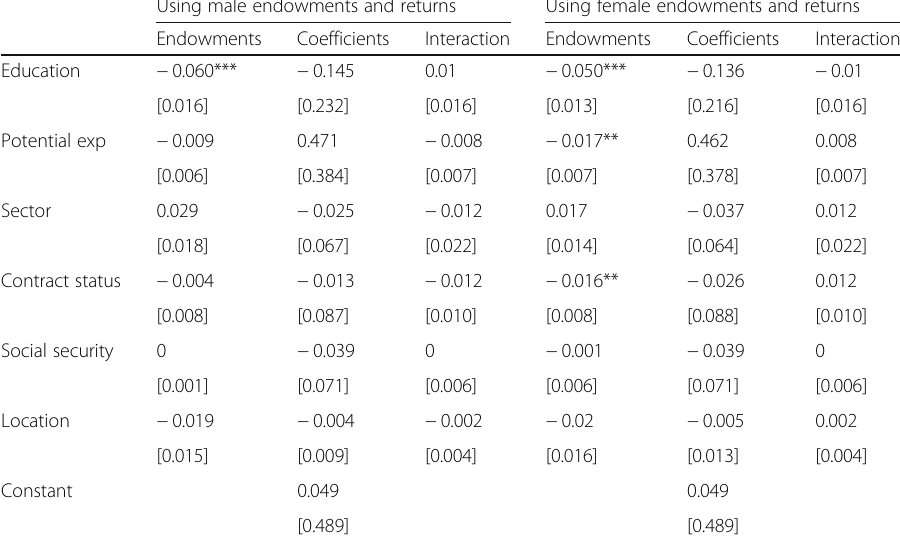
Table 14 Detailed threefold income decompositions: Kazakhstan Using male endowments and returns Using female endowments and